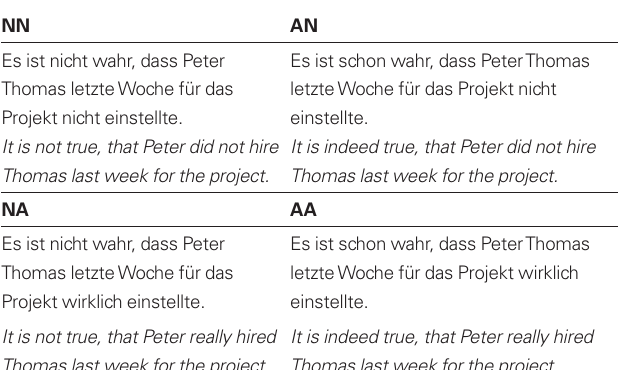
Table 1: Experimental conditions.